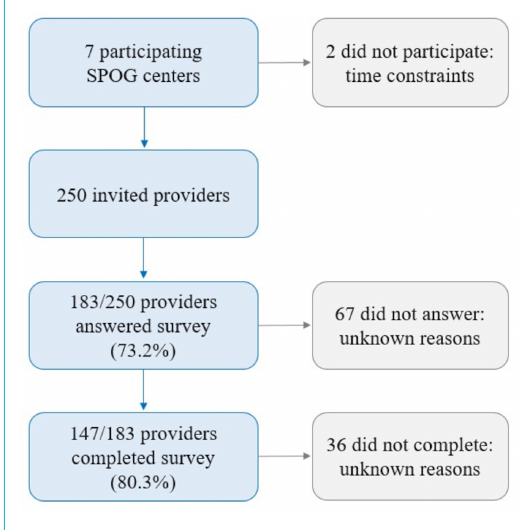
Figure 1: Flow chart of recruitment. SPOG: Swiss Paediatric On- cology Group